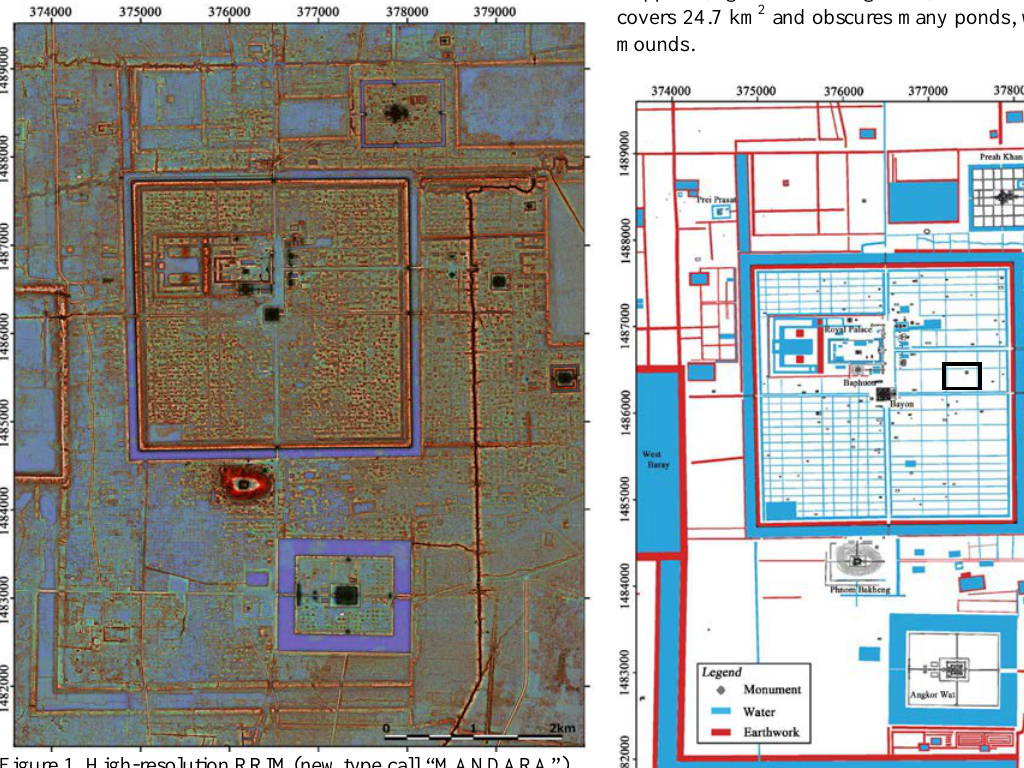
Figure 1. High-resolution RRIM(new type call “MANDARA”) of the central area of the Angkor Archaeological Park.